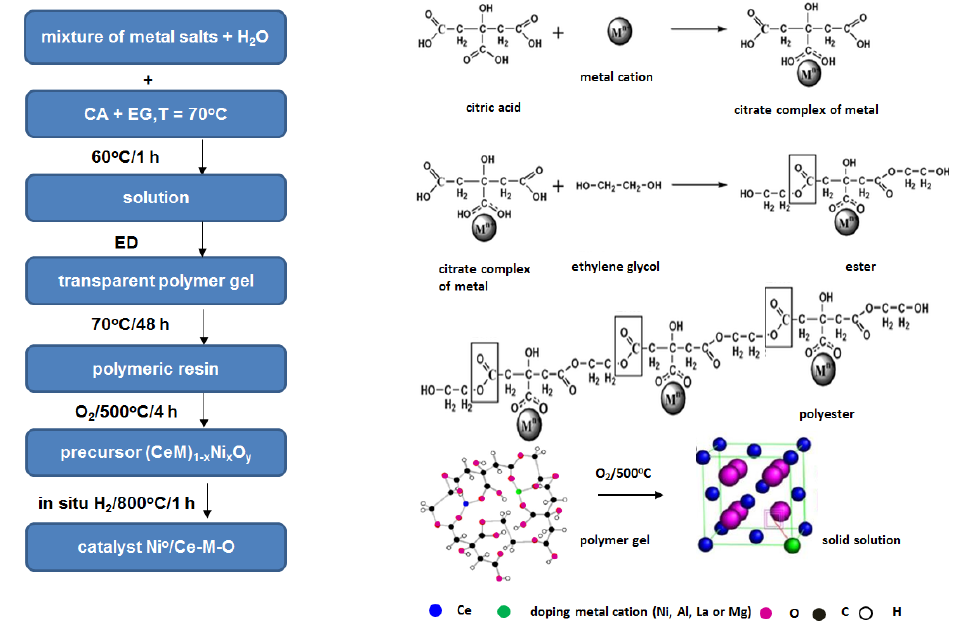
Figure 1. Scheme for the synthesis of (CeM) 1 − x Ni x O y (M = Al, La, Mg) solid solutions used as catalyst precursors in the polymerizable complex method.